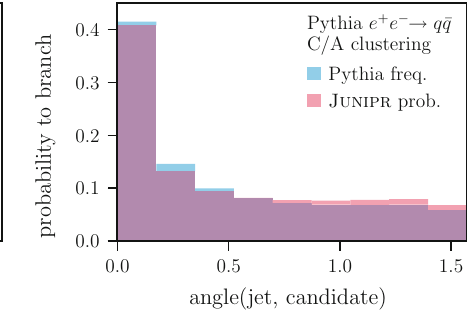
Fig. 8 Validation of P mother , the probability that a given candidate will branch next in the clustering tree. Comparison is made between actual outcomes in the validation set of Pythia jets and Junipr ’s probabilistic predictions for these jets. (Left) P mother at t = 10, as a function of a can-